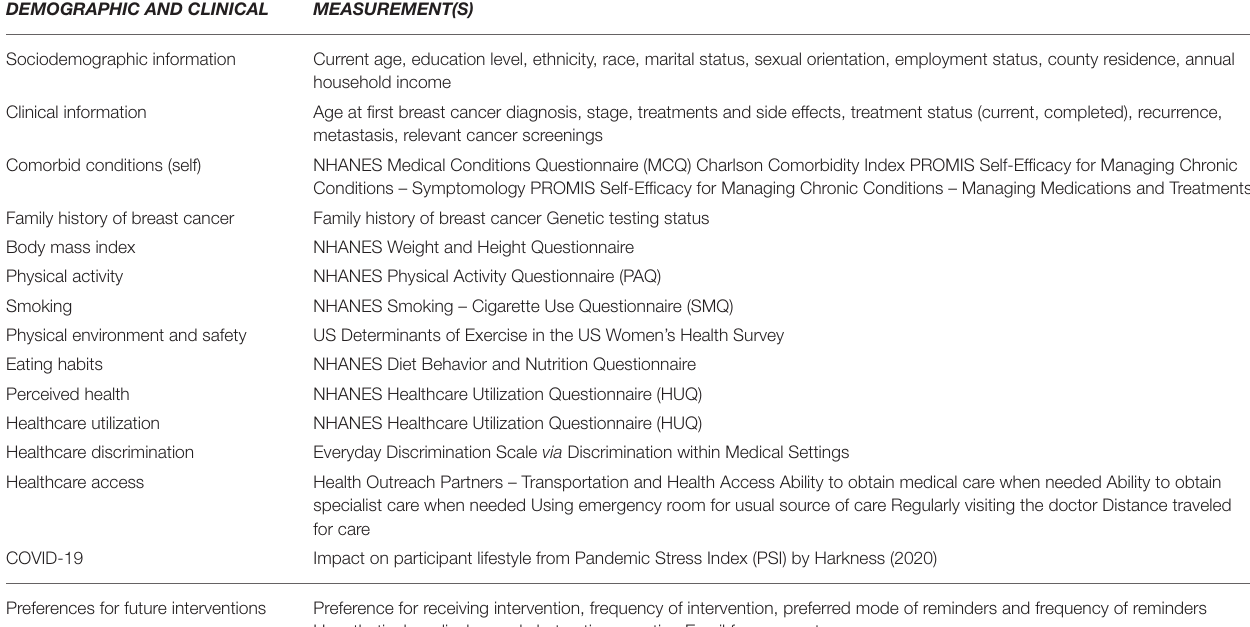
TABLE 1 | Variables collected through online survey of AA/ Black breast cancer